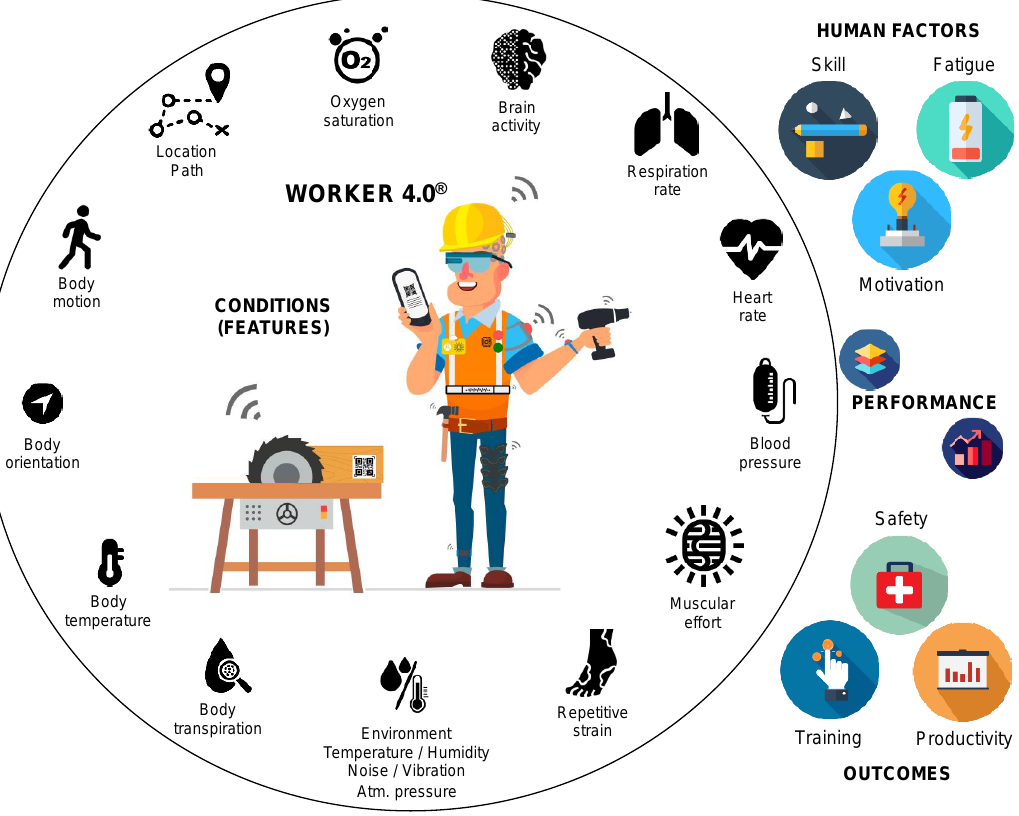
Figure 3. Worker 4.0: Human data generated.